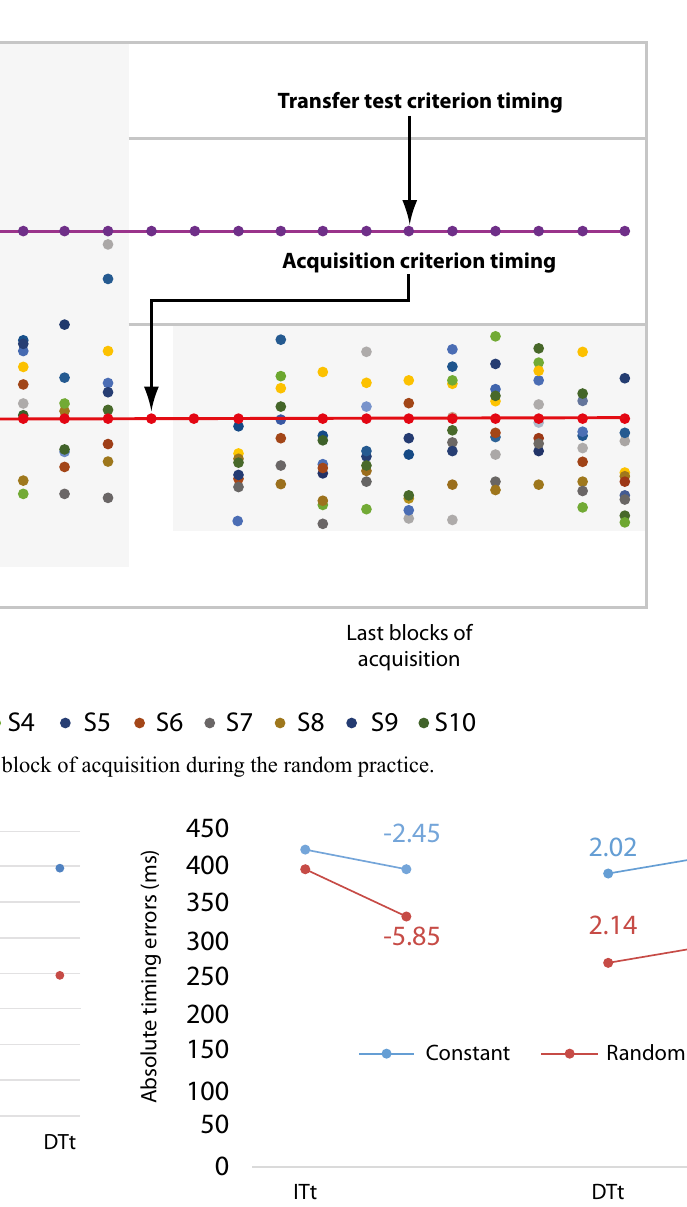
Figure 5. Absolute timing errors ( A E) in acquisition (blocks 1–10), immediate transfer test (ITt) and delayed transfer test (DTt).